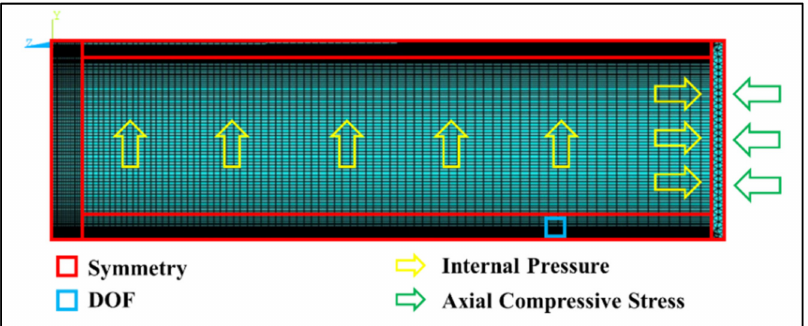
Figure 3. Application of symmetrical boundary conditions, internal pressure, axial compressive stress, and DOF constraints for quarter pipe